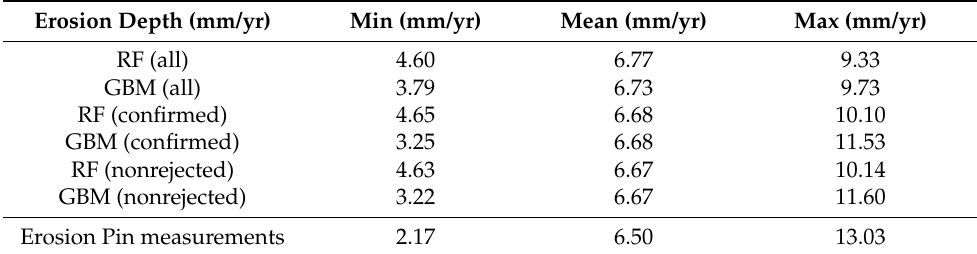
Table 4. Comparing ML model results with erosion pin measurements. Erosion Depth